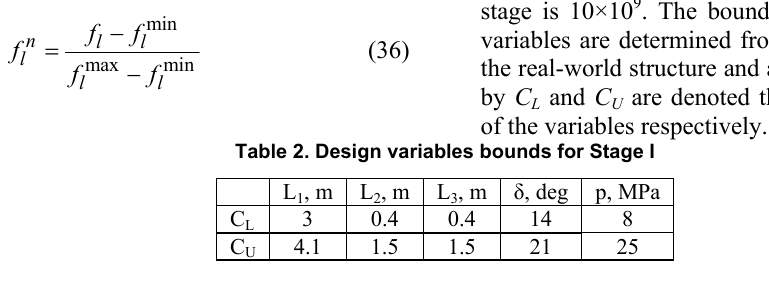
Table 3. Pareto optimal solutions - Stage I